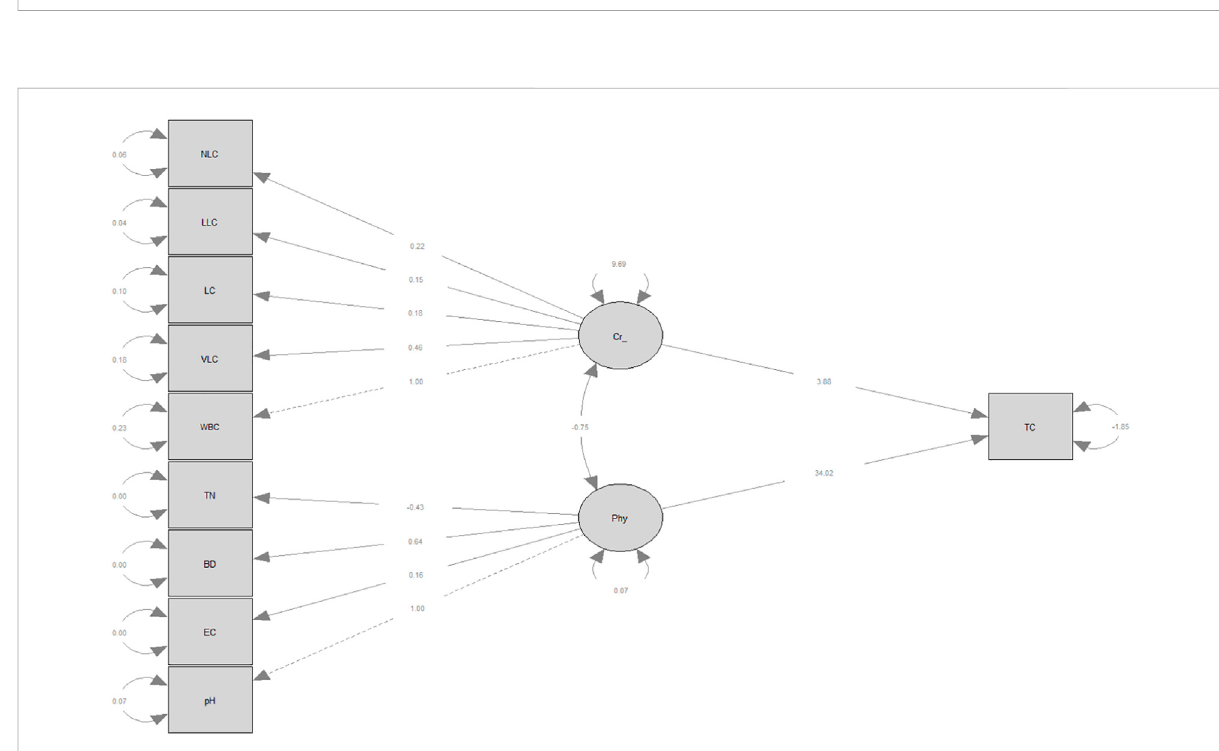
FIGURE 3 Structural equation modeling plot between soil properties and C